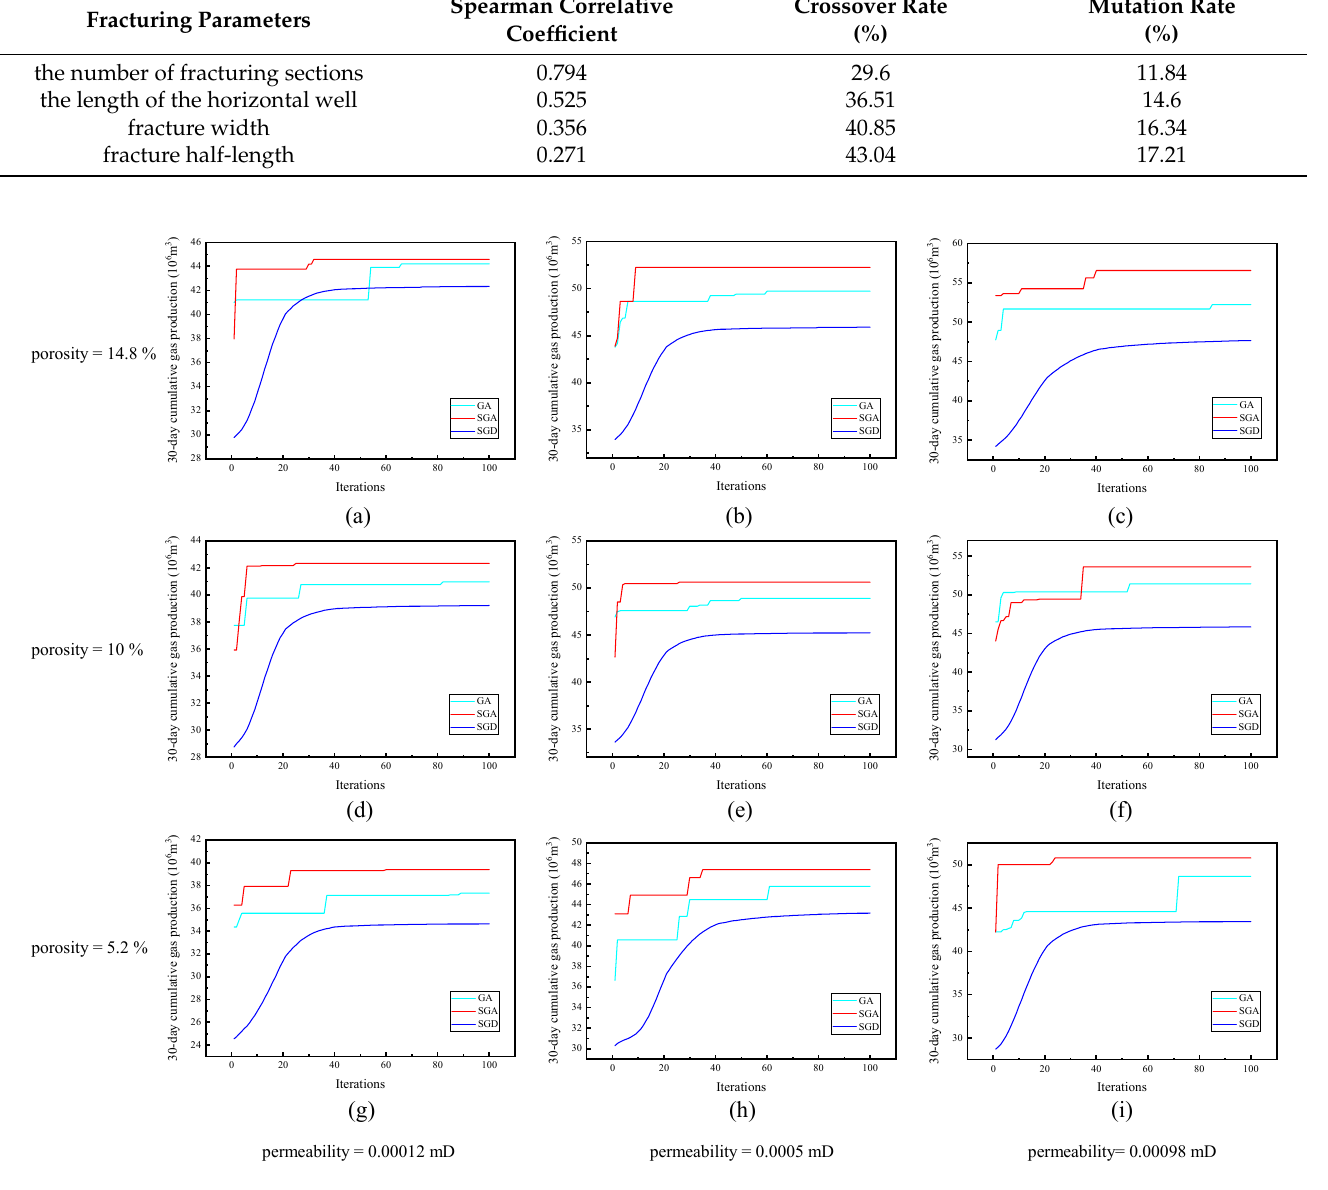
Figure 5. Comparison plots of GA, SGA, and SGD. The light-blue line denotes the optimization process of GA, and the red line represents the optimization process of SGA. The blue line is the optimization process of SGD. ( a – i ) denote the optimization results of the production prediction models with different porosities and